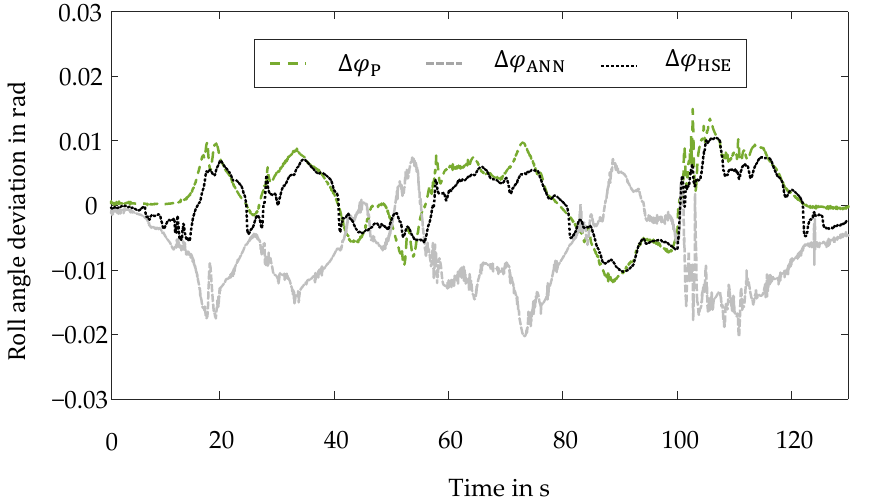
Figure 8. Hybrid Method of State Estimation-Hockenheimring Racetrack: Roll Angle Deviation Curves. Table 3. Estimation Quality